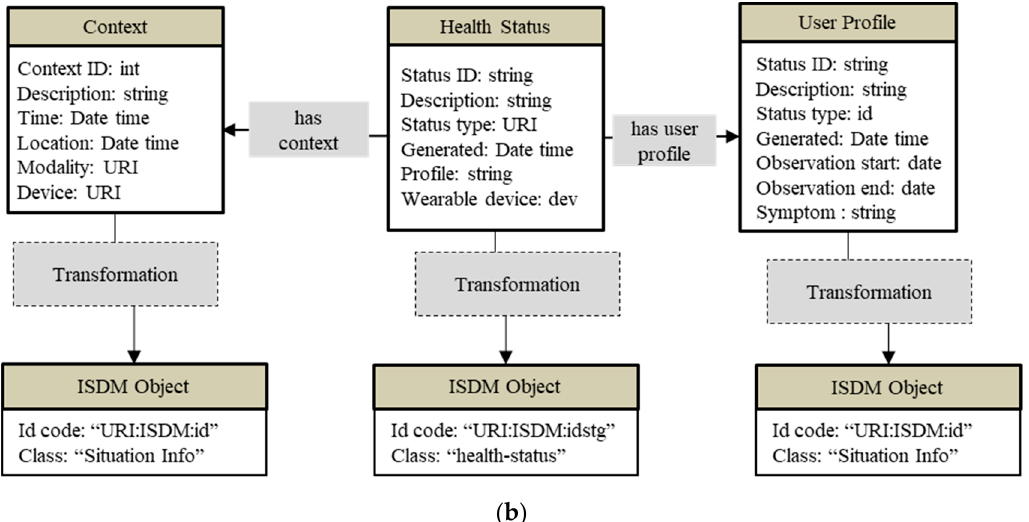
Figure 12. ( a ) A model of CDM as an Interoperable Shared Data Model (ISDM) with transformation process to shared data representation along with standard vocabulary, core and meta schemas. ( b ) An example of transformation to the Interoperable Shared Data Model (ISDM) through extracting entities from the domain-specific data model with their metadata description and their translation from the concepts of a domain to the generic entities.